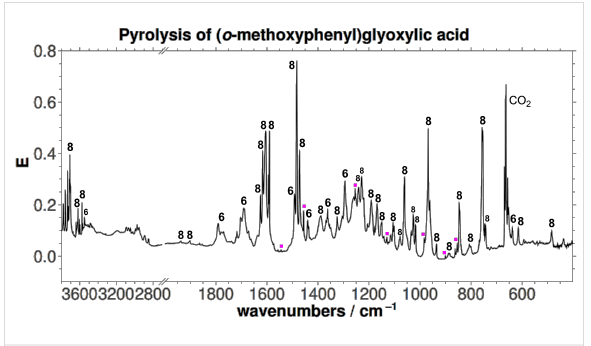
Figure 1: Unmodified matrix IR spectrum (Ar, 11 K) of the pyrolysis (600 °C) of 5 . Traces of 9 are indicated by magenta dots.